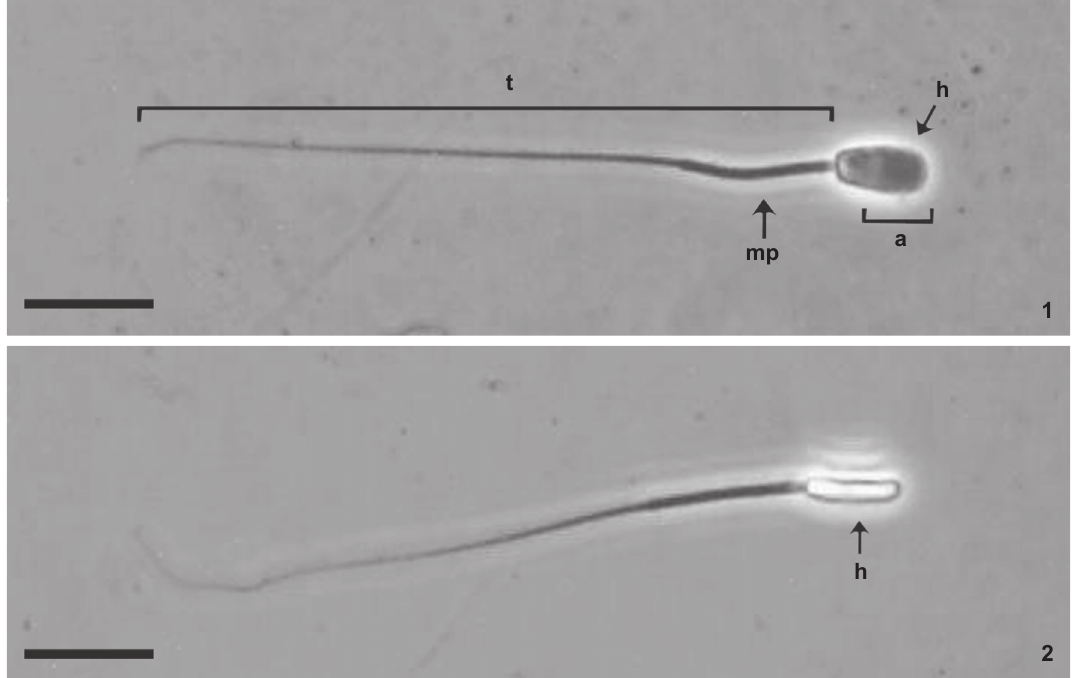
Figures 1-2. Light micrographs of T. inunguis spermatozoa in frontal view (1) and lateral view (2). (h) Head, (t) tail, (a) acrosome, (mp) midpiece. Scale bar = 10